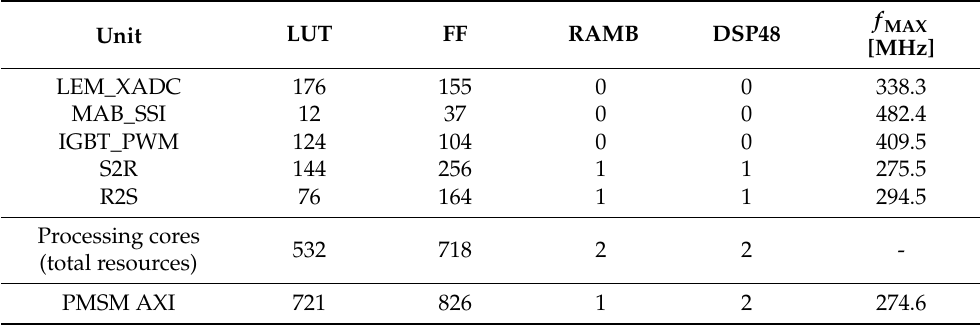
Table 3. Resource requirements and performance of elementary components and complete interface system for PMSM control implemented in